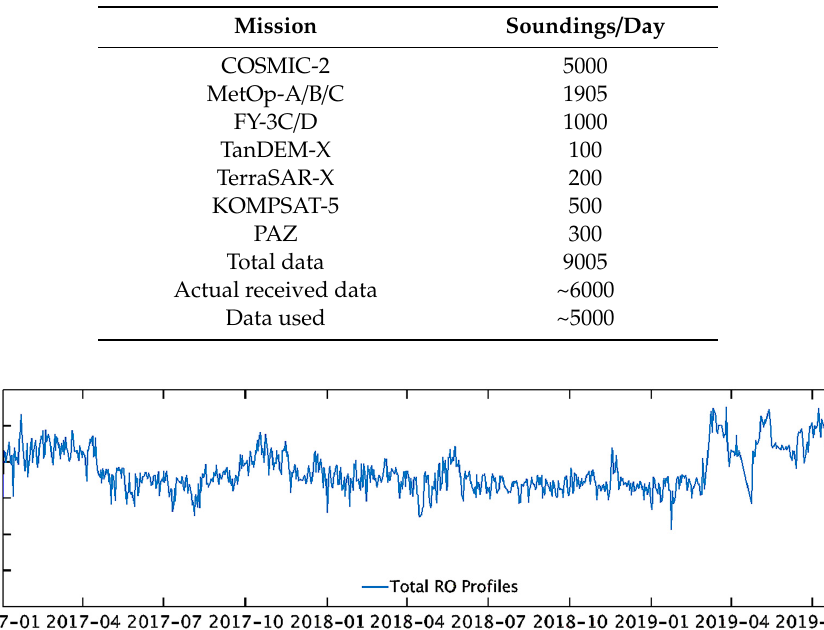
Figure 8. Daily total RO profiles in the National Centers for Environmental Prediction (NCEP) Global Data Assimilation System (GDAS) from 01/2017 to 09/2019. Taken from [47].